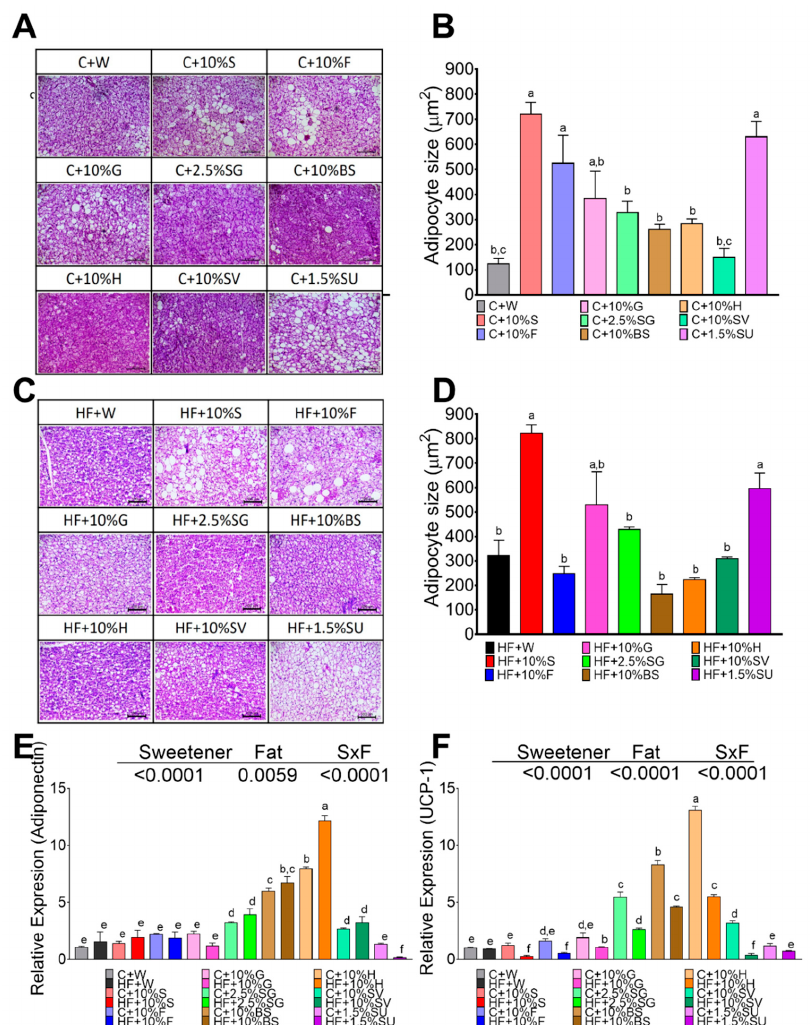
Figure 5. E ff ect of type of sweeteners on histological morphology and expression of adiponectin and UCP-1 in brown adipose tissue. Hematoxylin-Eosin staining (HE) of BAT of rats fed di ff erent sweetener with control ( A ) or high fat diet ( C ). Brown adipocyte size ( B , D ); Relative expression of adiponectin ( E ) and uncoupling protein 1 (UCP-1) ( F ). The data are expressed as the mean ± SEM ( n = 6). Results were considered statistically significant at p < 0.05. Significant di ff erences among groups are indicated by letters, where a > b > c > d > e >